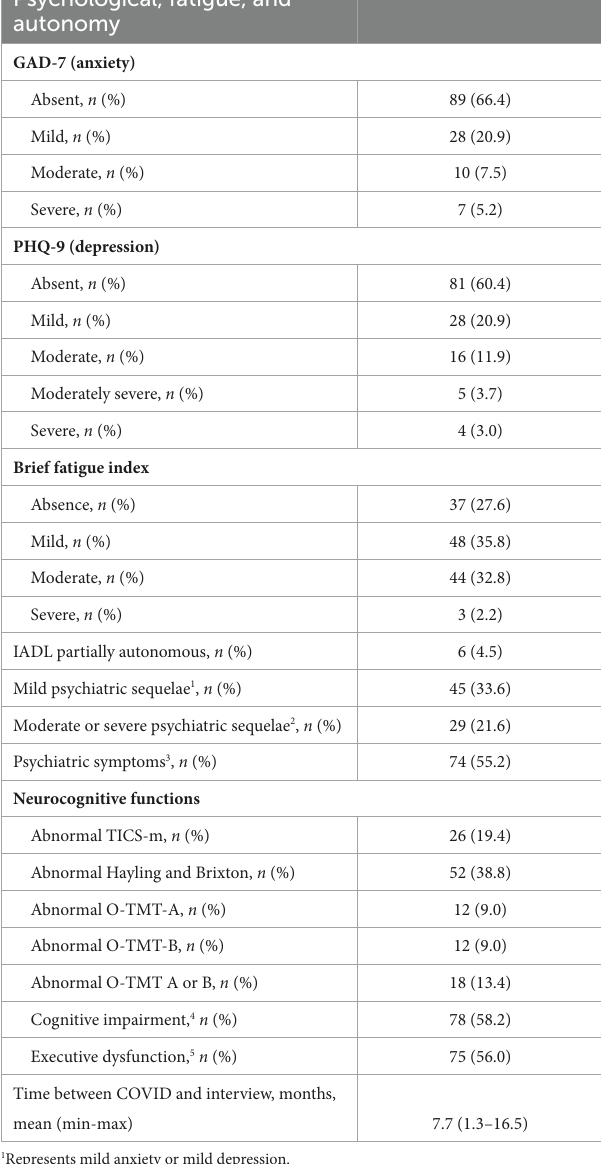
Psychological, fatigue, and